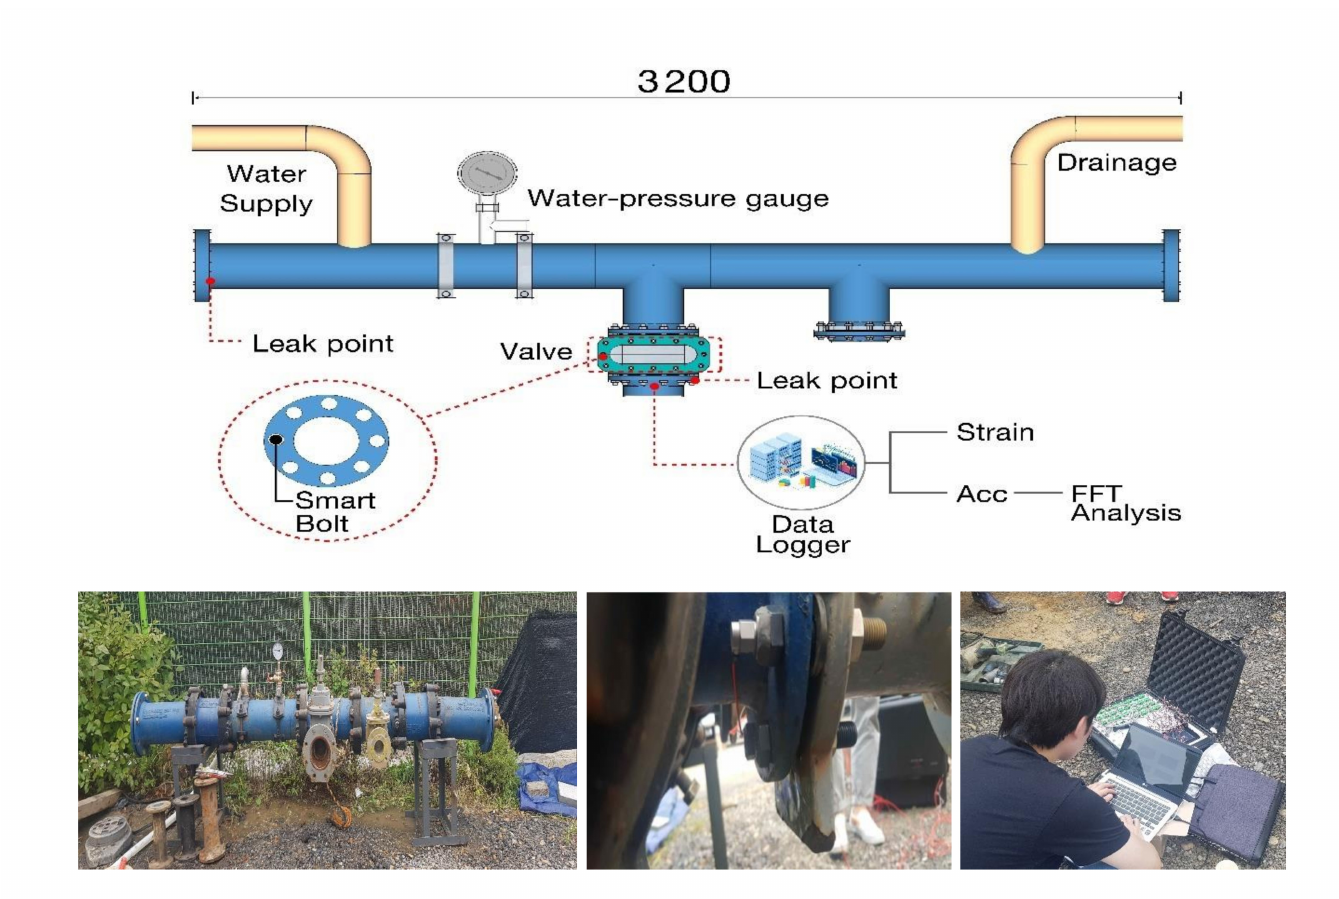
Figure 5. Simulated leak piping system.